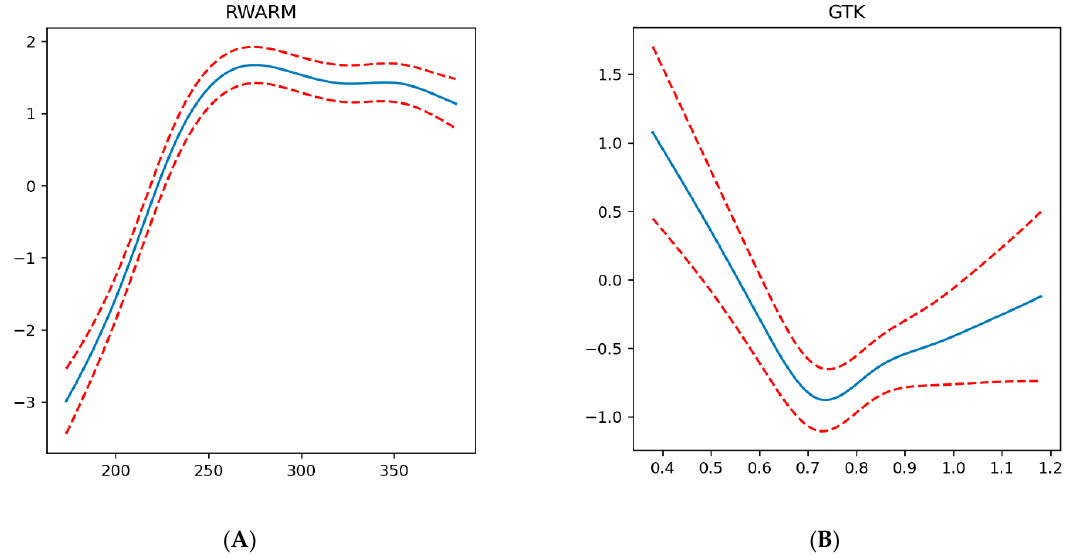
Figure 15. Dependence of rill erosion density on mean annual precipitation in the warm period (mm) ( A ) and the value of the hydrothermal coefficient (GTK) ( B ) in the basin.